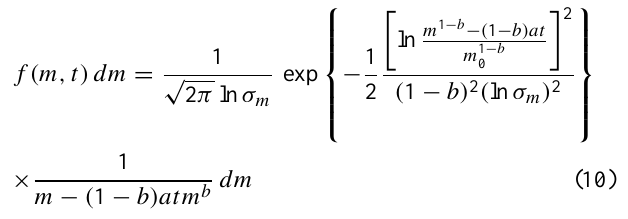
Fig. 2. Total fraction of number loss, φ n , vs. total fraction of mass loss, φ m , for various initial geometric mean masses from 1 to 1000 ng. Note that the curves are almost congruent. Time runs along the curves from (0 , 0) to (1 , 1) .